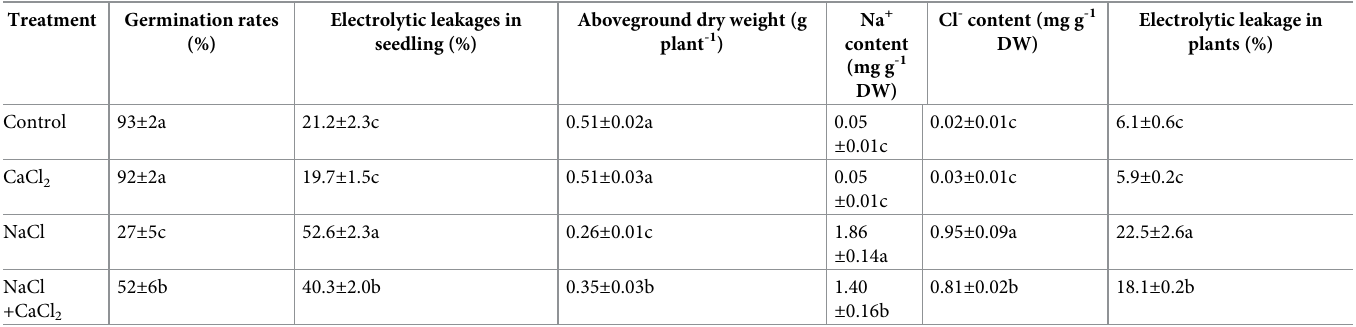
Table 1. Germination rate, electrolytic leakages of oat seedlings in the control (water), CaCl 2 (10 mM), NaCl (150 mM), and NaCl (150 mM) + CaCl 2 (10 mM) treat- ments on day 7 after NaCl stress and aboveground dry weight, Na + and Cl - content, and electrolytic leakages of oat leaves in the control (nutrient solution), CaCl 2 (10 mM), NaCl (300 mM), and NaCl (300 mM) + CaCl 2 (10 mM) treatments on day 15 after NaCl stress. Cl - content (mg g -1 Treatment Germination rates Electrolytic leakages in Aboveground dry weight (g Na + Electrolytic leakage in (%) seedling (%) plant -1 ) content DW) plants (mg g -1 DW)